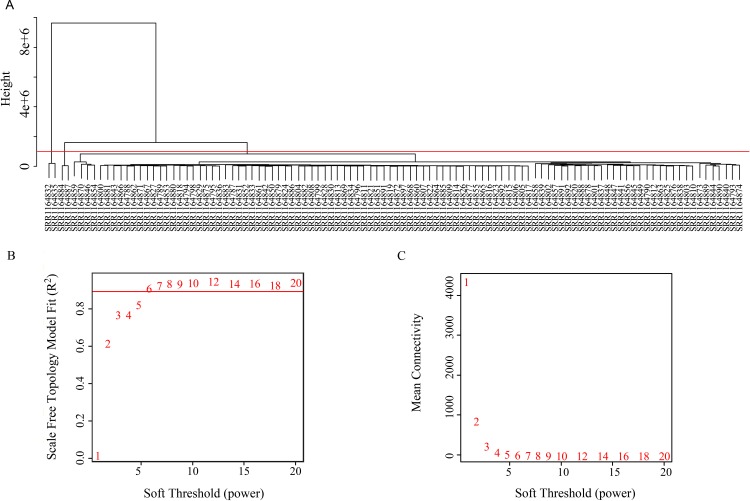
(A) Clustering tree of 106 samples. (B) Soft threshold corresponding scale independence and (C) mean connectivity.